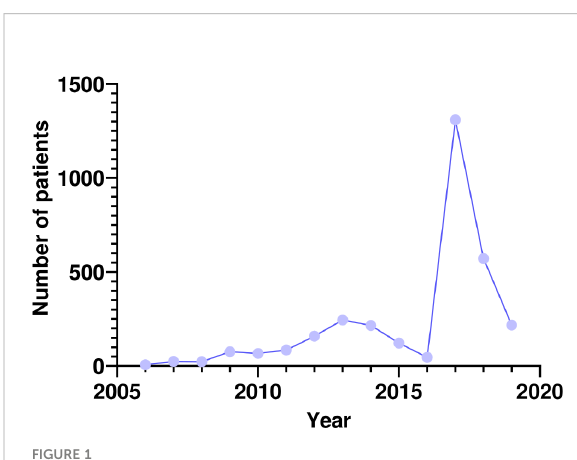
FIGURE 1 Trend of referral of Libyan patients with cancer between 2006 and 2019. Number of cases (n=3170) had signi fi cantly increased after the fi rst the Libyan civil war in 2011. A surge of cases coincided with the Libyan Ministry of Health and KHCC treatment agreement signed in 2017.